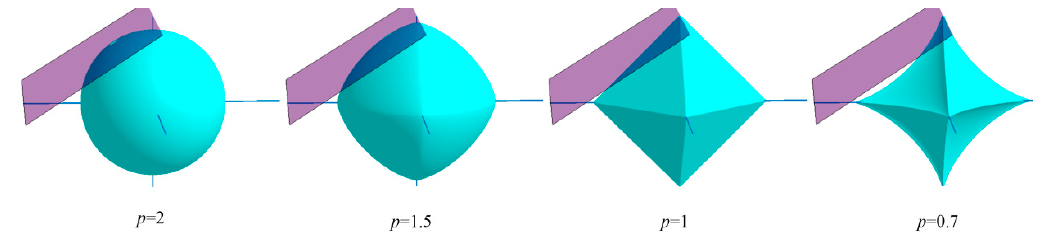
ff erent values of p